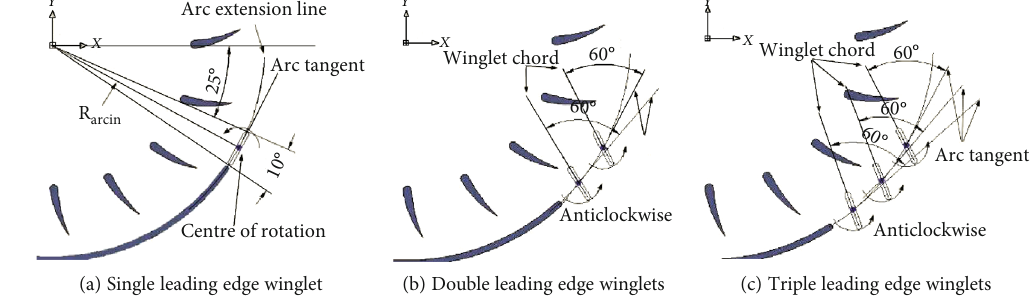
Figure 2: Design of leading edge winglet of Fan-wing.